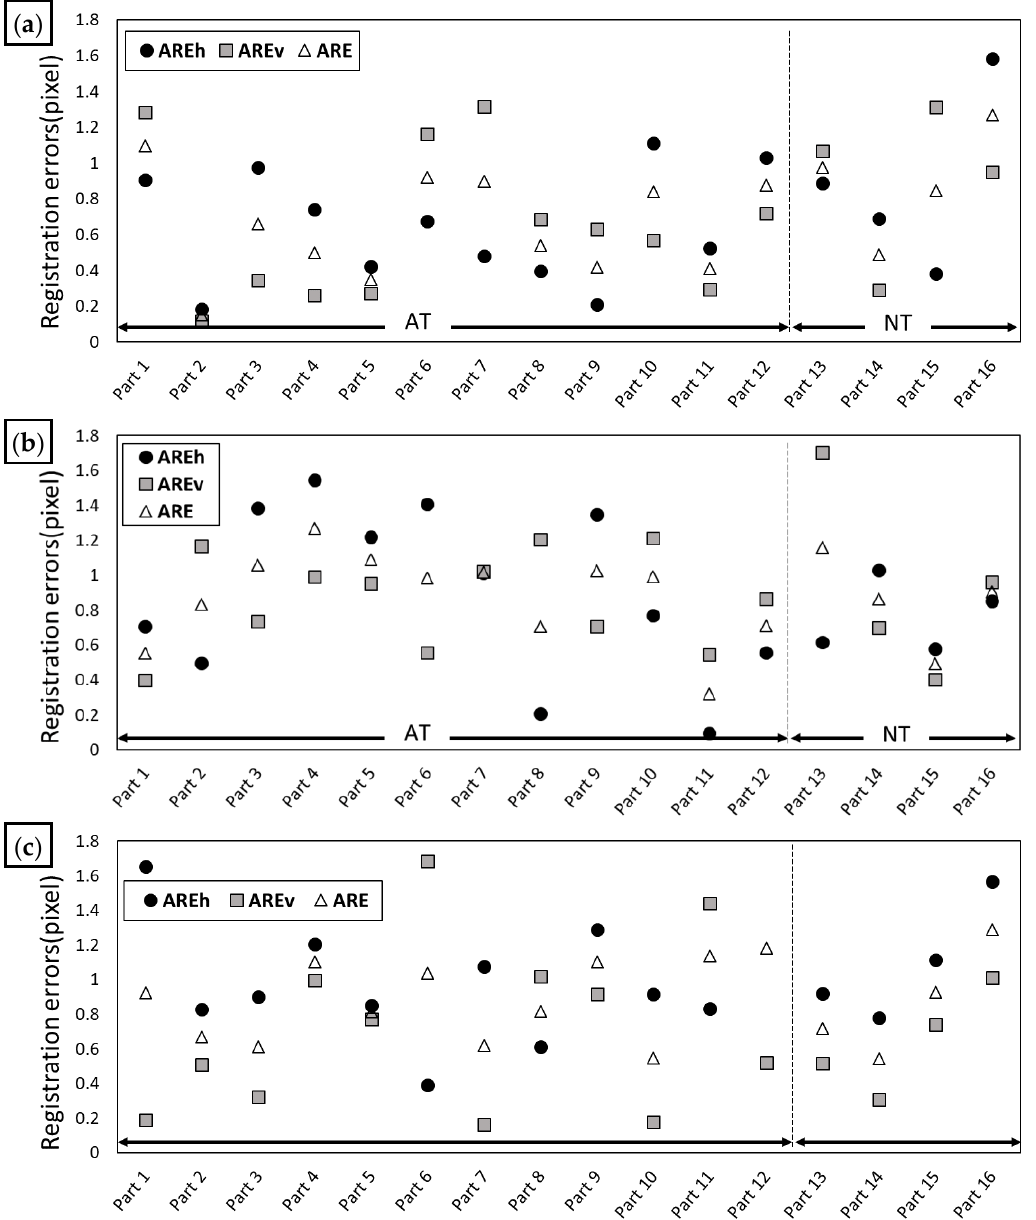
Figure 14. Distribution of ARE h , ARE v , and ARE for three types of behaviors. ( a ) Facing displacement; ( b ) Settelemt; ( c ) Combined displacement. Table 3. Average values for feature performance evaluation of KAZE method with ATs and NTs. Average of All